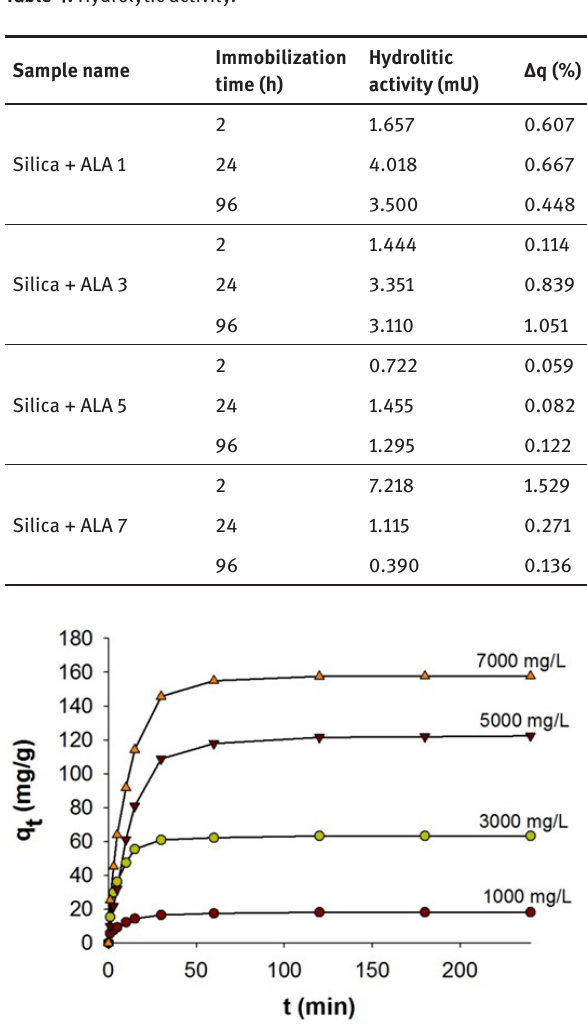
Table 4: Hydrolytic activity.